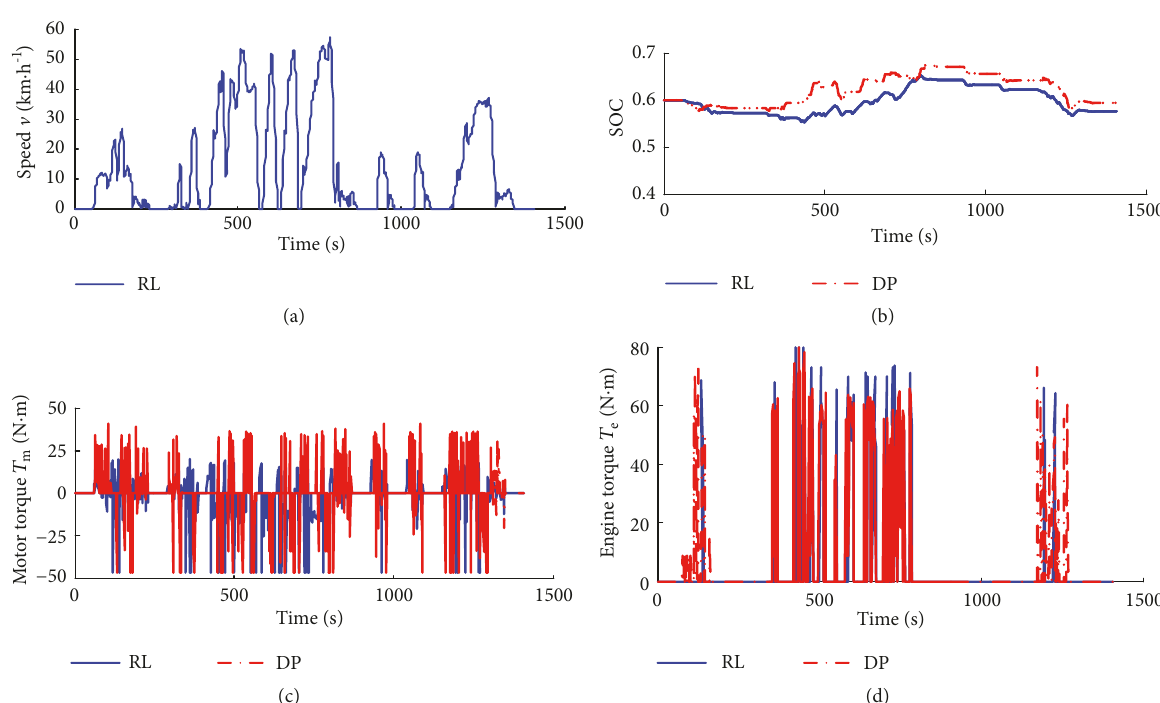
Figure 13: Comparison between DP and RL optimization results based on CYC